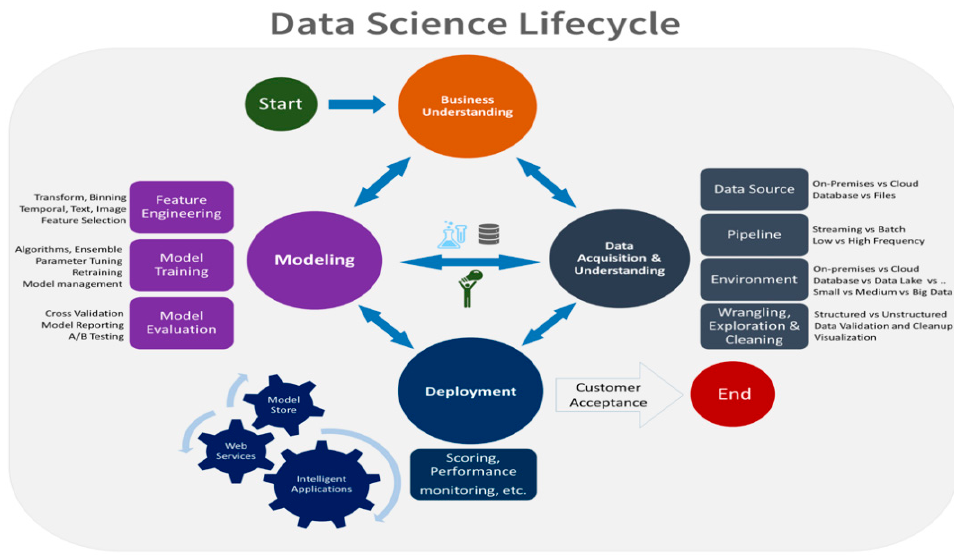
Figure 4. TDSP methodology (Source [28]).